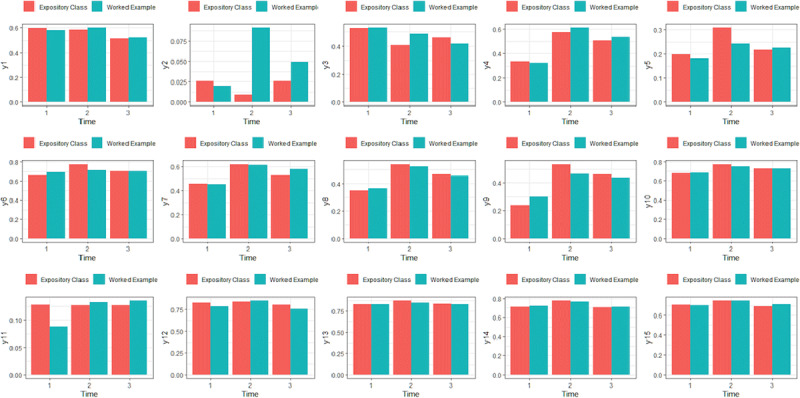
Proportions of correct answers by individual question for the conventional and experimental groups.